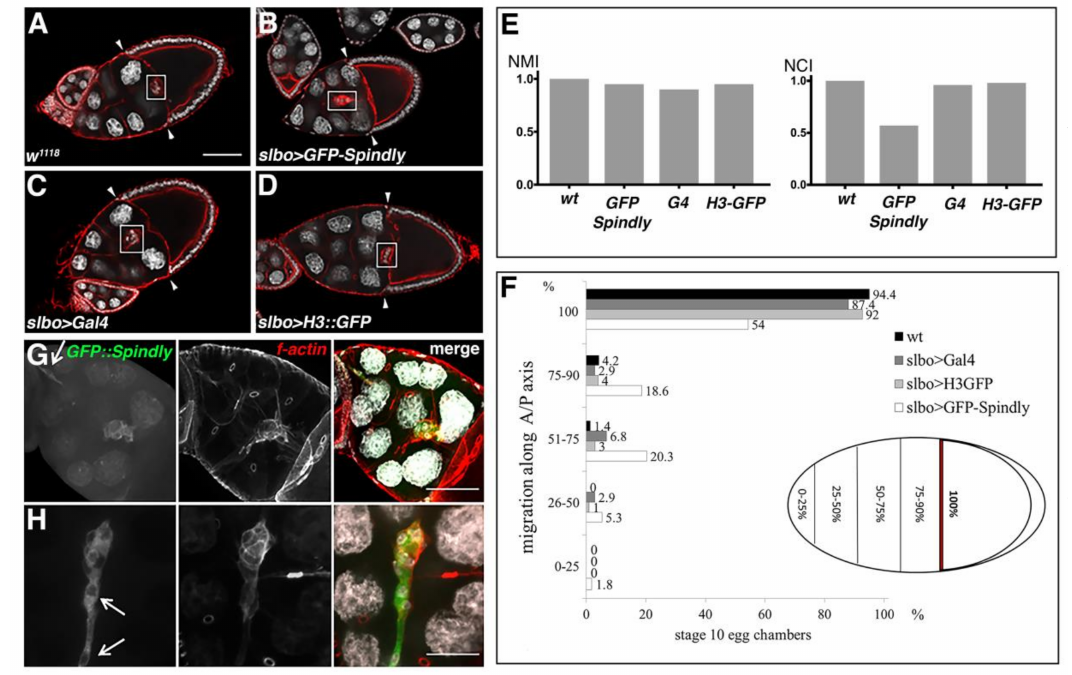
Figure 8. Spindly overexpression in migrating ovarian border cells. ( A – D ) Confocal optical sections of fixed and immunolabeled egg-chambers at stage 10 of oogenesis of the indicated genotypes. Migration of border cells was delayed by GFP::Spindly overexpression ( B ) compared to w 1118 ( A ), slbo>Gal4 ( C ) and slbo>Gal4;H3::GFP ( D ) ( slbo>H3::GFP ) as controls. Arrowheads indicate the border between squamous and columnar follicle epithelium DAPI (grey); f-actin (red); scale bars: 50 µ m; ( E ) Comparison of normalised migration indices (NMI) and normalised completion index (NCI); ( F ) Quantification of the phenotype described in ( E ). 46% of the clusters overexpressing Spindly did not complete migration by stage 10 of egg-chamber development ( n = 113); ( G ) Morphology of border cell clusters in egg chambers of slbo>Gal4; UAS>GFP::Spindly females. Confocal optical section of stage 10 egg-chambers (maximum-intensity projection of 10 µ m z-stack at a spacing of 1 µ m). Loss of border cell cluster integrity is marked by white arrows. In 11,5% of cases the border cell cluster had lost integrity or in most severe cases single cells had detached from the main cluster ( H ) and migration was delayed ( n = 113) (DAPI (grey), f-actin (red), GFP (green); scale bars represent 20 µ